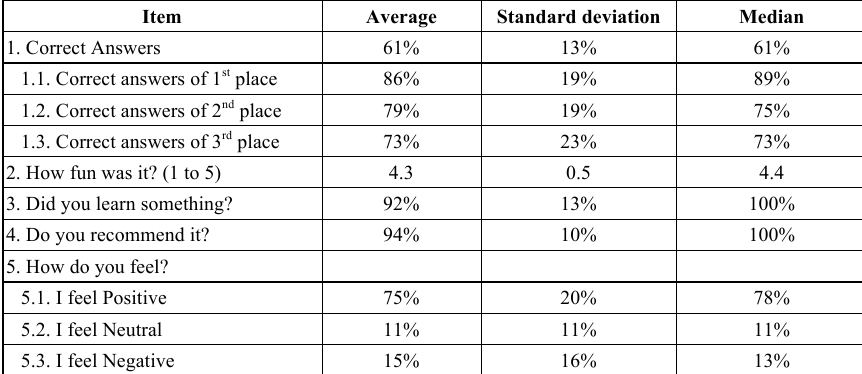
Table 2. Results of Kahoot acceptability and applicability